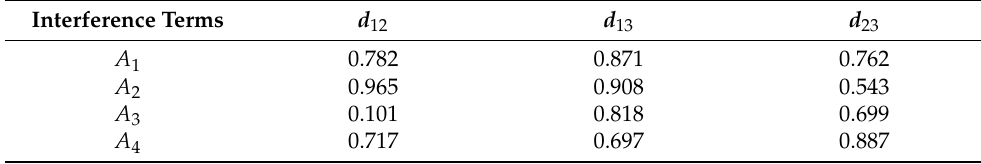
Table 10. The value of interference terms of LDAS i .